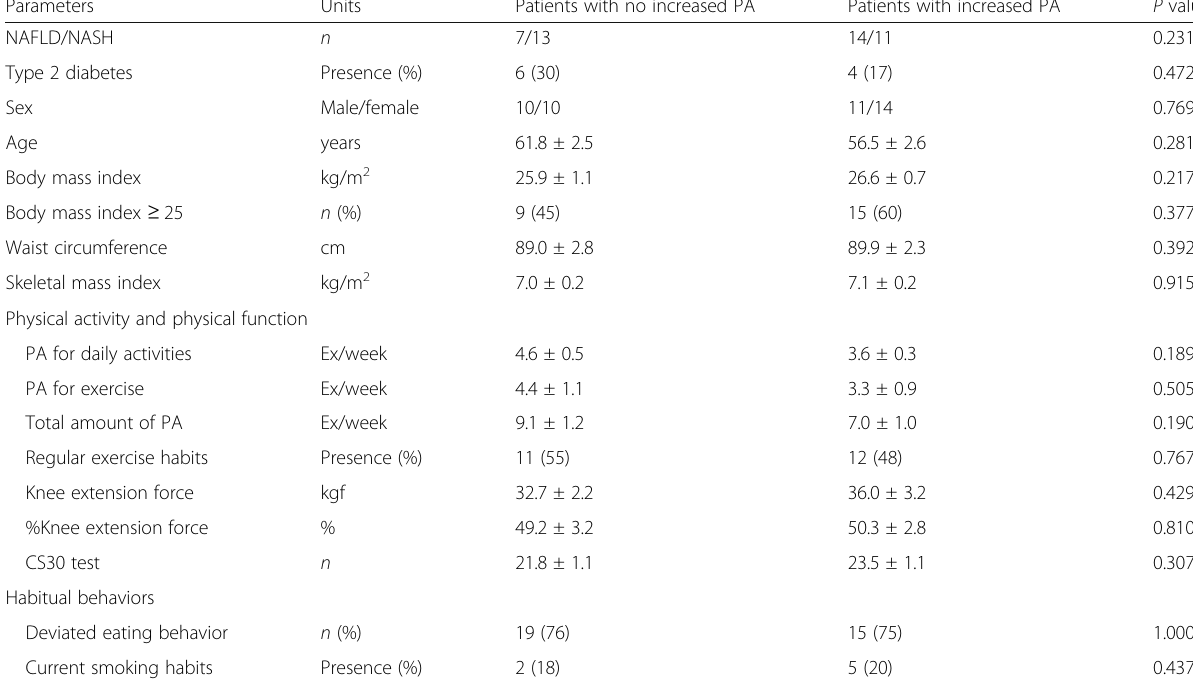
Table 1 Baseline characteristics of patients with nonalcoholic fatty liver disease grouped by physical activity Parameters Units Patients with no increased PA Patients with increased